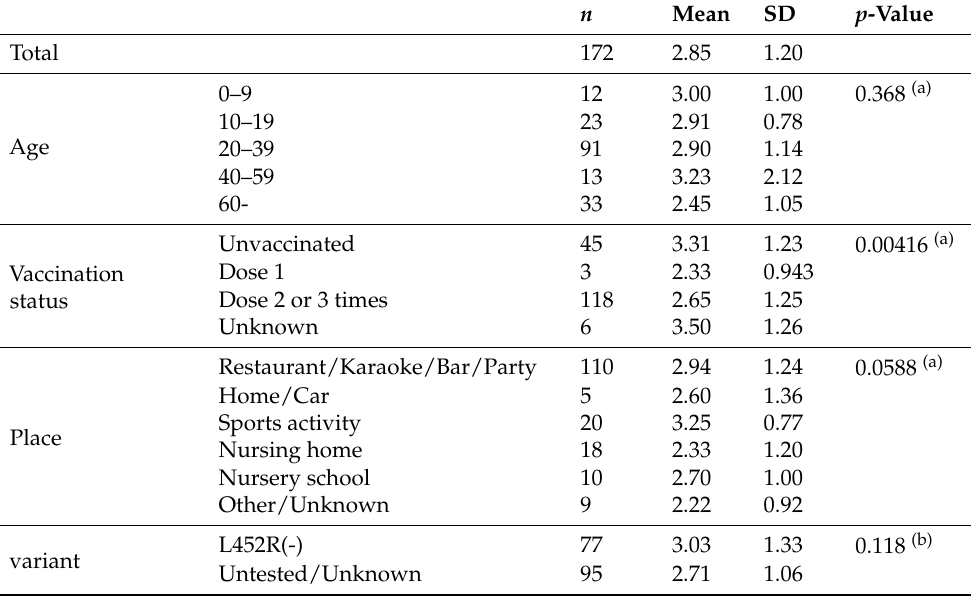
Table 1. Incubation period among Japanese COVID-19 patients diagnosed in January